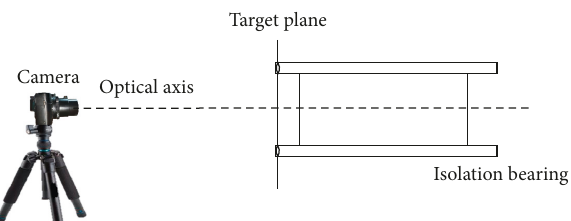
Figure 2: The relationship between the camera and the target